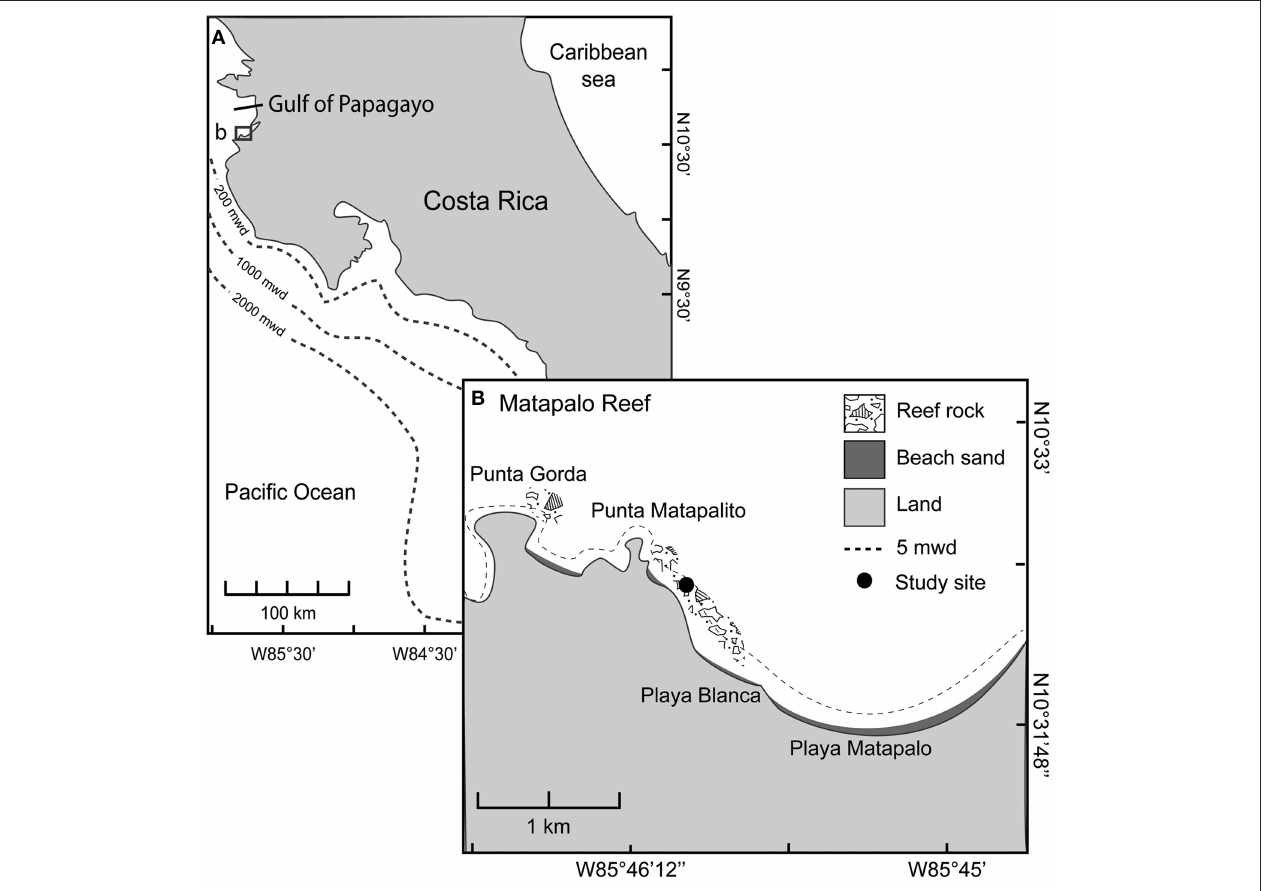
FIGURE 1 | Study site. (A) Location of Matapalo Reef along the northern Pacific coast of Costa Rica. (B) Incubations and benthic surveys took place at 5m water depth (mwd) at the indicated study site (10 ◦ 32 ′ 21 ′′ N, 85 ◦ 45 ′ 59 ′′